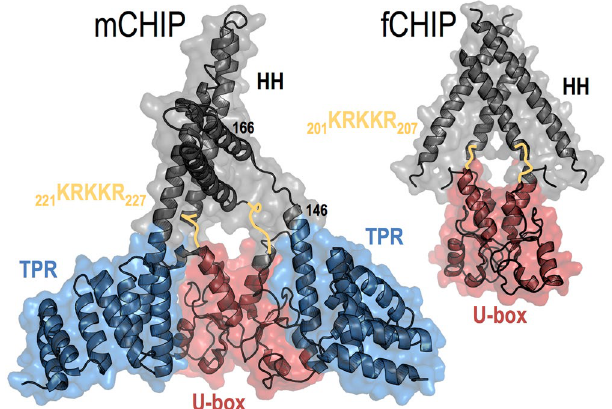
Figure 1. Crystal structures show asymmetric CHIP (mouse; PDB 2C2L) and symmetric fCHIP (Zebrafish; PDB 2F42) without the TPR domain. Blue mesh depicts the TPR domains. Grey mesh indicates the helix-turn- helix (HH) dimers. Red mesh shows U-box dimers. Gold lines highlight the basic residues 221-to-227 linking the HH domains and the